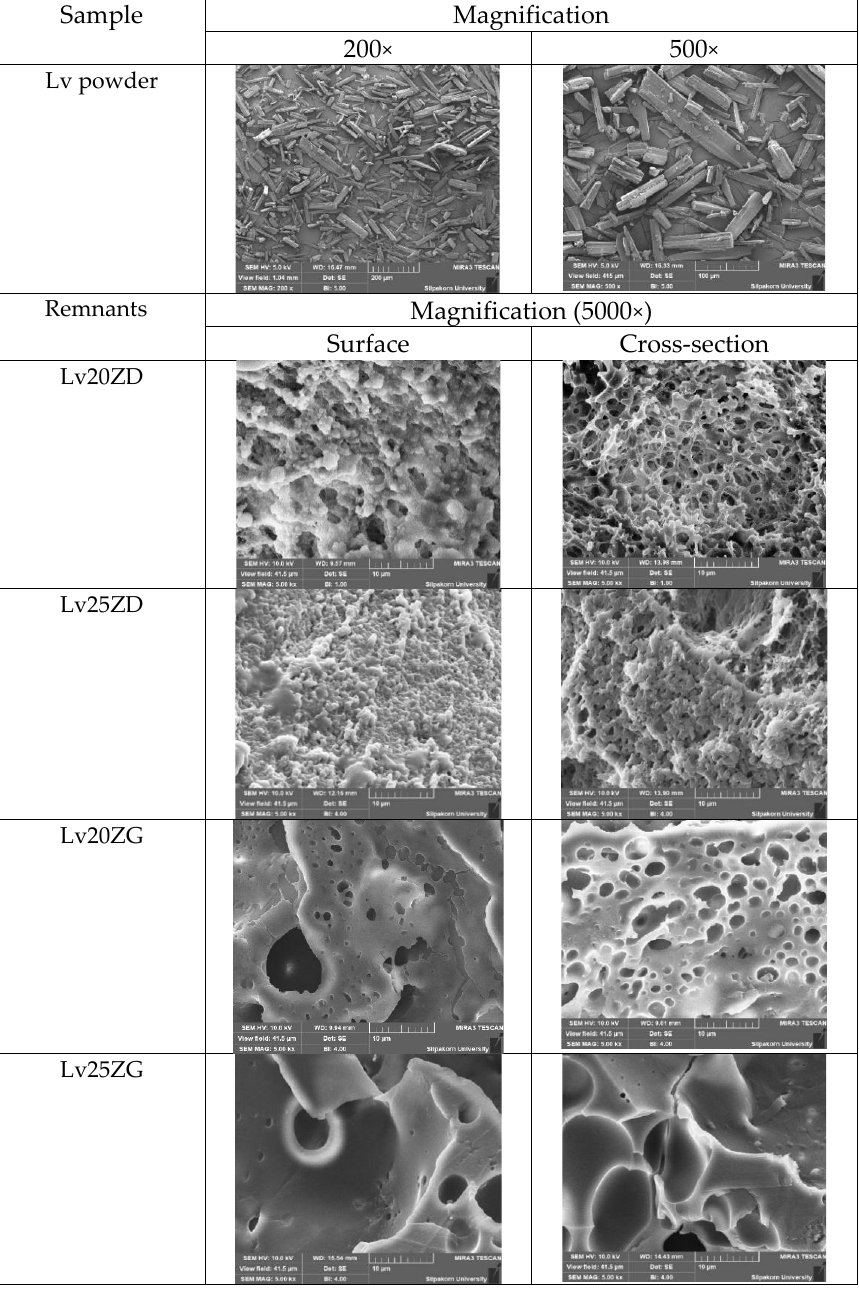
Figure 6. SEM images of intact Lv powder at different magnifications and freeze-dried Lv-loaded zein-based ISGs at a magnification of 5000×.